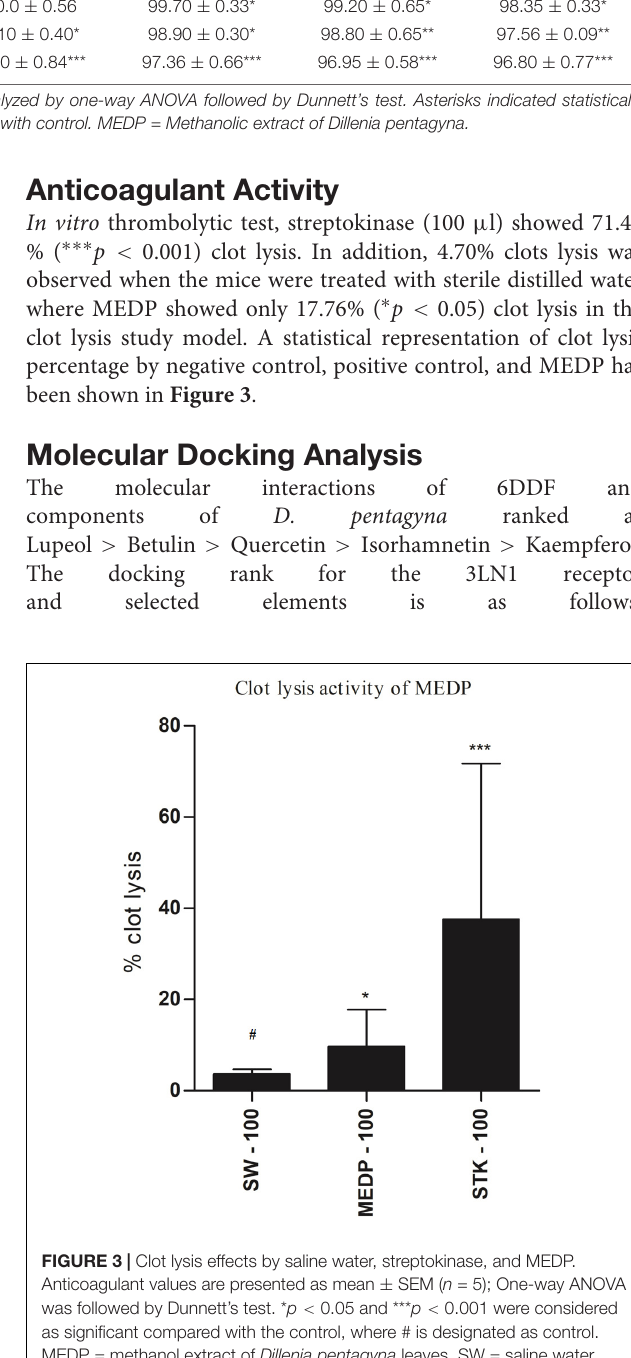
TABLE 2 | Antipyretic activity of the methanol extracts of Dillenia pentagyna in yeast induced pyrexia method. Group Initial rectal Rectal temperature at yeast injection and after the administration of sample ( ◦ F) temperature before After 18 h 1st hour yeast injection ( ◦ F) Control (Tween – 10 mg/mL)